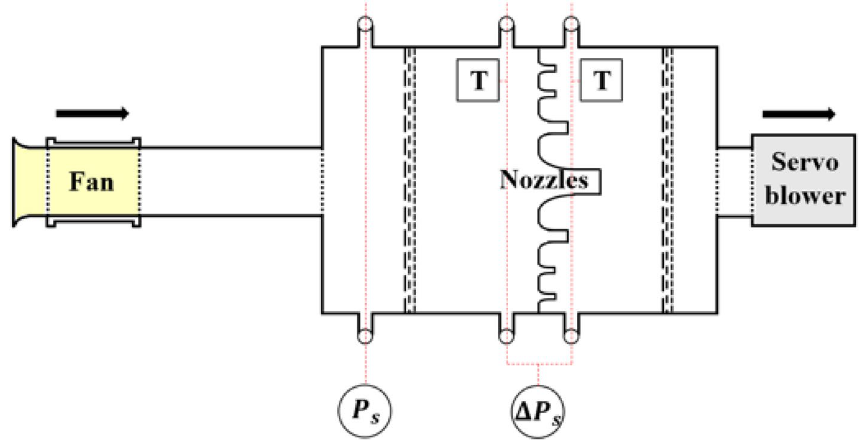
Figure 6. Schematic diagram of experimental test facility for outlet chamber setup.